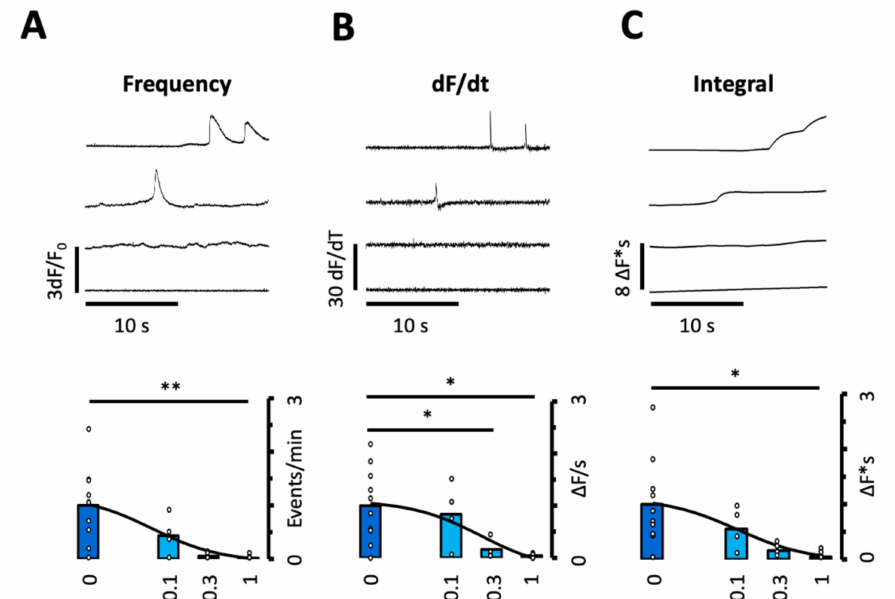
Figure 4. Effect of R-Carvedilol on calcium wave frequency and properties. The frequency and properties of spontaneous calcium transients or waves were recorded in myocytes after addition of Feno and increasing doses of R-Carv (given below bars). ( A ) Event frequency. ( B ) Rate of rise of the calcium signal. ( C ) Time integral of the calcium signal. Data are from 40 cells/10 patients. p -values were obtained using ANOVA test with Welch correction followed by Bonferroni-adjusted multiple comparisons. Statistically significant differences between pairs of bars are indicated with *: p < 0.05, **: p < 0.01. Solid lines represent fitting using a Hill equation. Circles in ( A – C ) correspond with the values of individual data